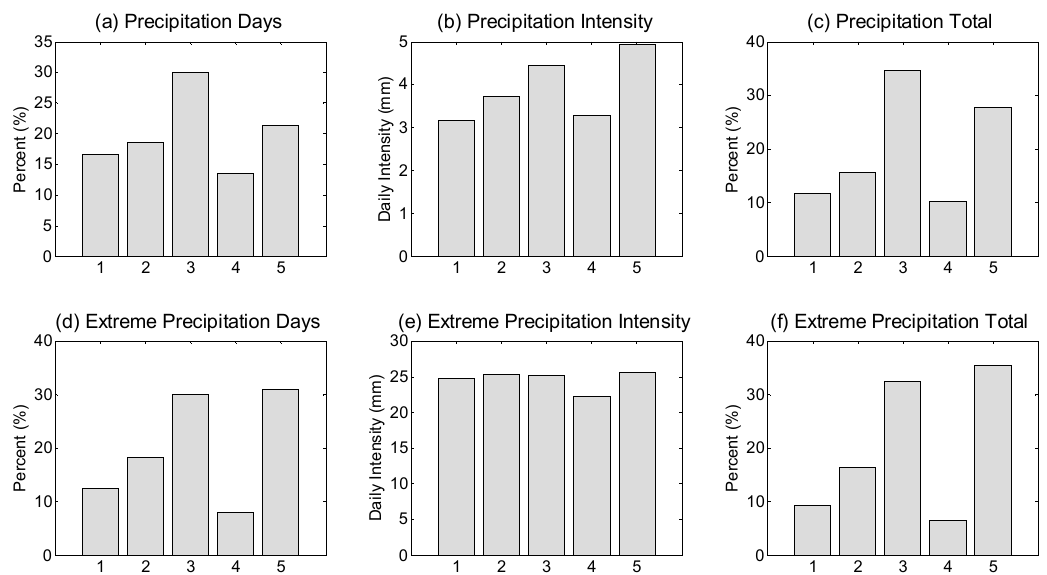
Figure 6. Mean precipitation characteristics of CHEN05 for December–January–February (DJF) 1979-2005. ( a ) The number of precipitation days (expressed as a percentage of all precipitation days) for each WT. ( b ) The mean daily precipitation intensity (mm / day) for each WT. ( c ) The mean total precipitation (%) for each WT. ( d – f ) Precipitation days, intensity, and totals for extreme precipitation, defined as the top 1% of precipitation daily intensity.